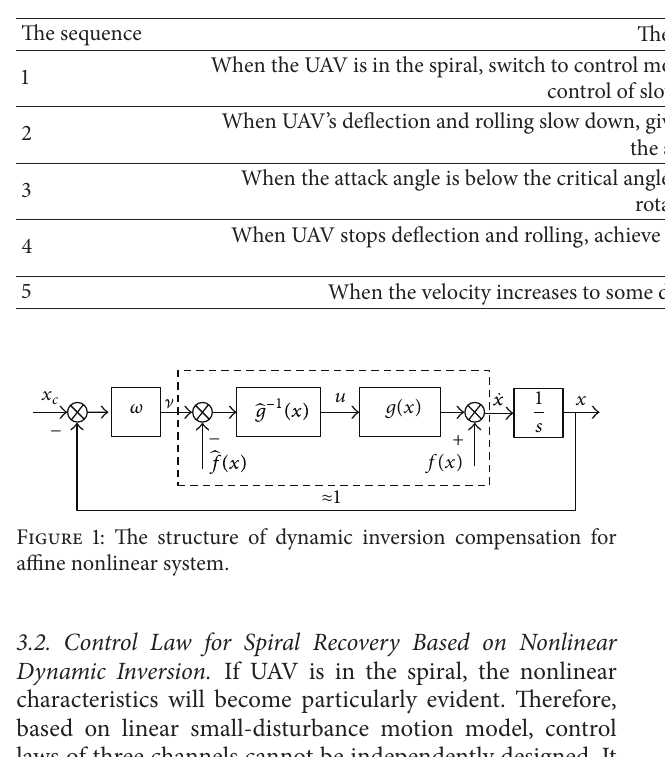
Table 1: Control sequence of spiral recovery.